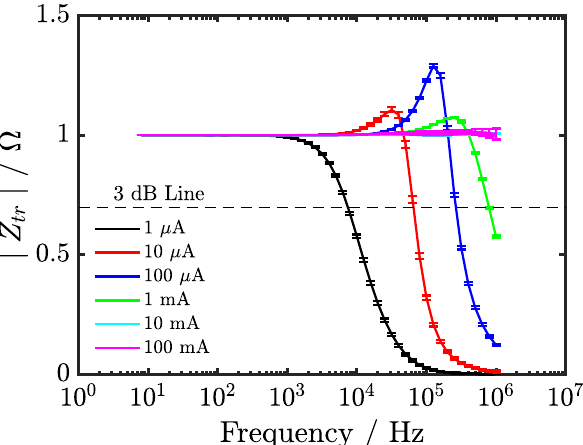
Figure 2. The plot of the magnitude of the transimpedance of the potentiostat ( | Z tr | ) at different current range versus frequency. The plot shows the 3 dB line, which allows for the bandwidth of the potentiostat at different current ranges to be read off.